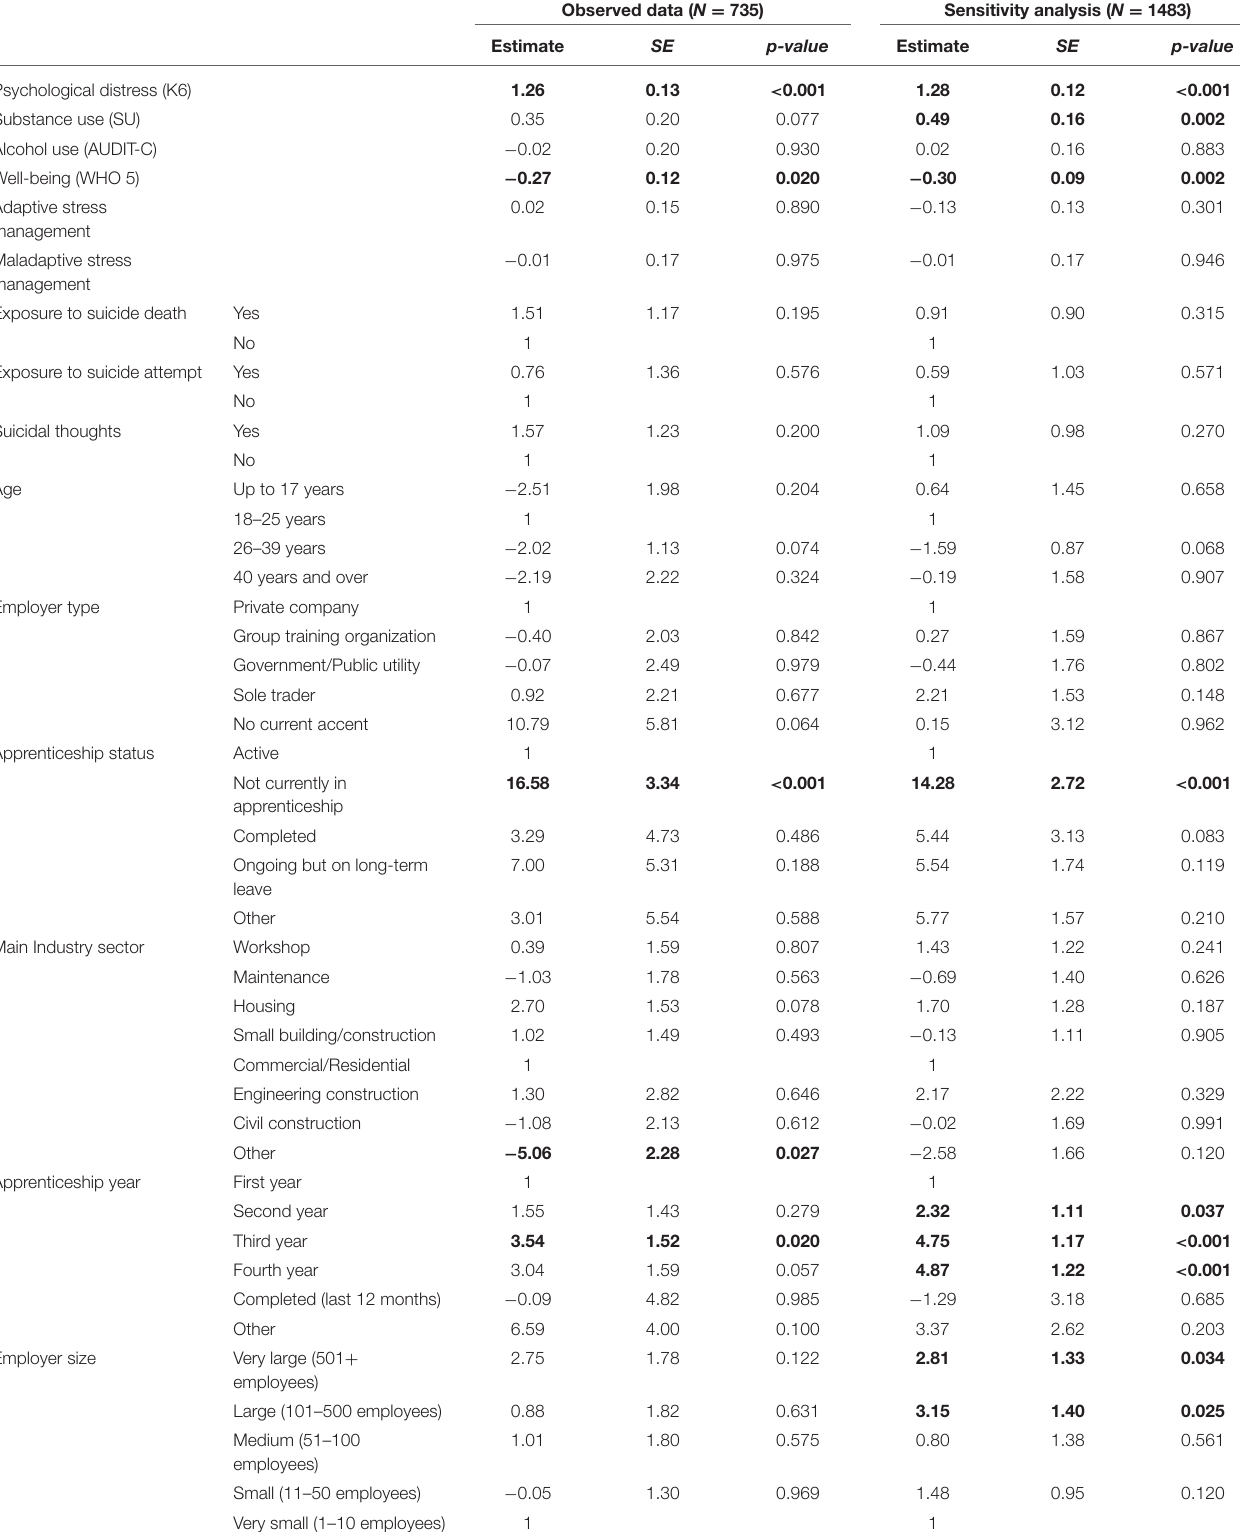
TABLE 6 | Final mixed-effects linear regression models of self-reported bullying